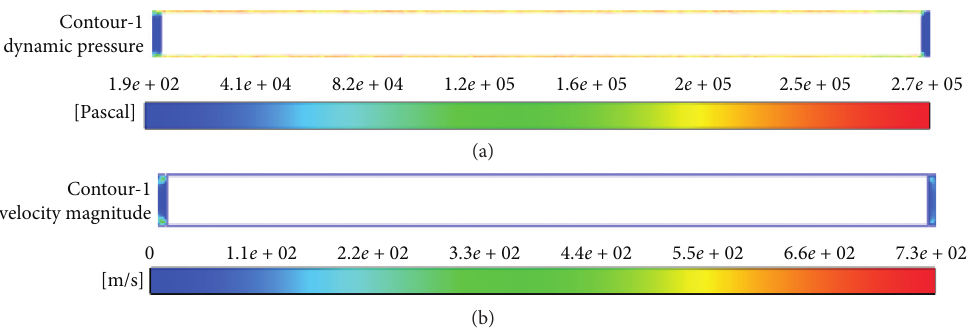
Figure 3: Distribution of flow field in annular flow passage. (a) Dynamic pressure distribution. (b) Velocity distribution.